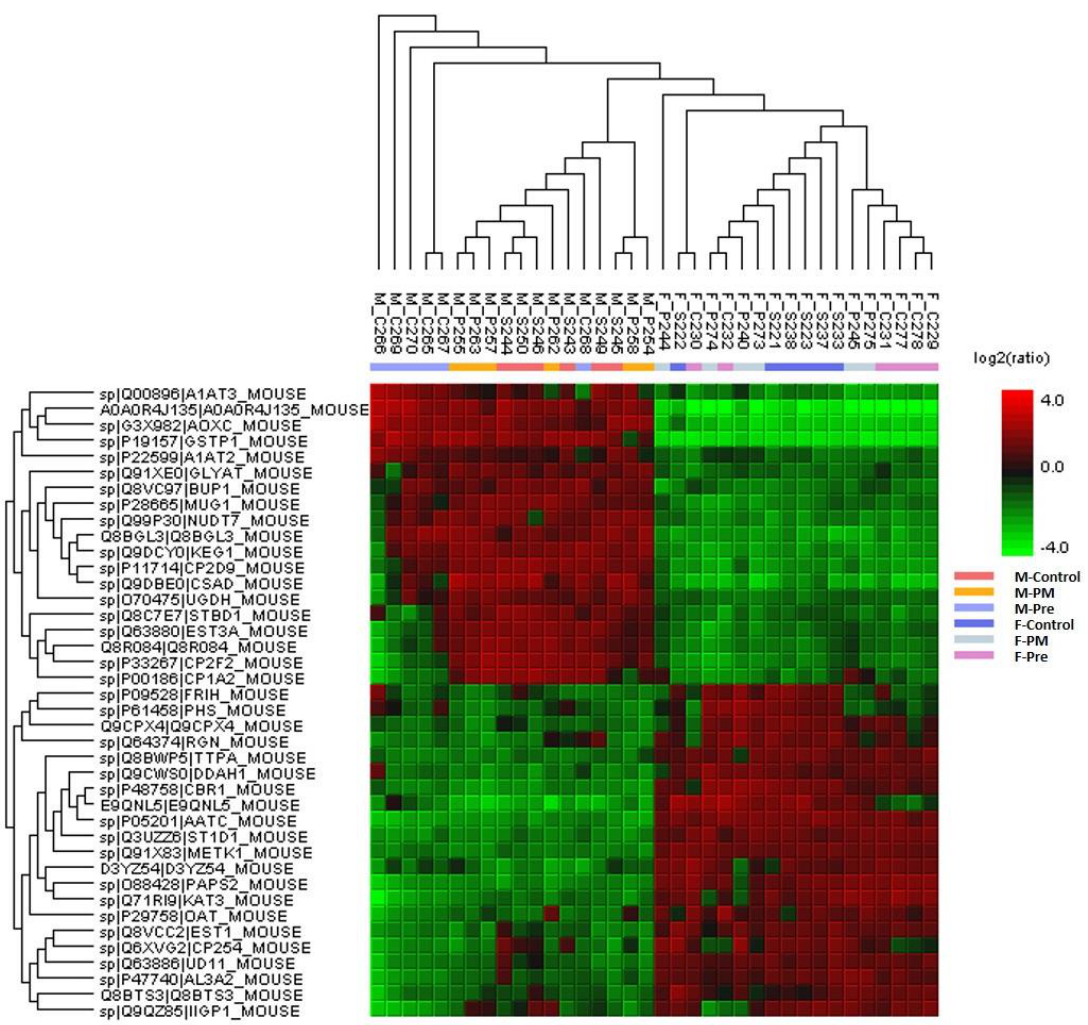
Figure 5. Protein profile heatmap from Peak Studio XPro. Cell colour represents the log2(ratio) to the average abundance across different samples, highlighting the distinct sex-specific differences in protein abundance. n = 6 for each group. PM: offspring from dams continuously exposed to PM 2.5 ; Pre: offspring from dams exposed to PM2.5 before conception only.